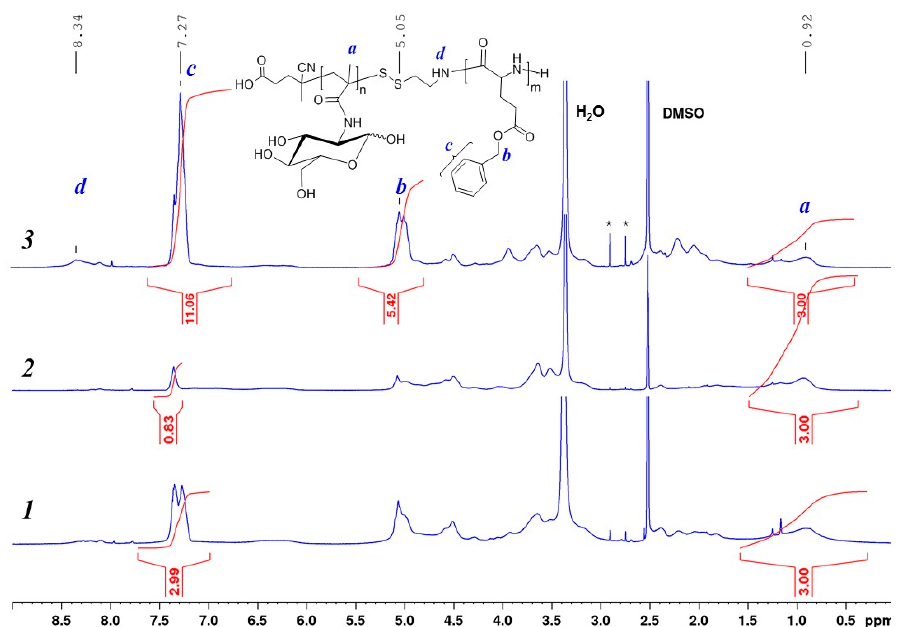
Figure 5. 1 H NMR spectra (DMSO-d 6 , 25 °C) of block copolymers PMAG- b -P(Glu(OBzl)) with di ff erent composition (Table 2): 1 —sample b 4, 2 —sample b 1, 3— sample b